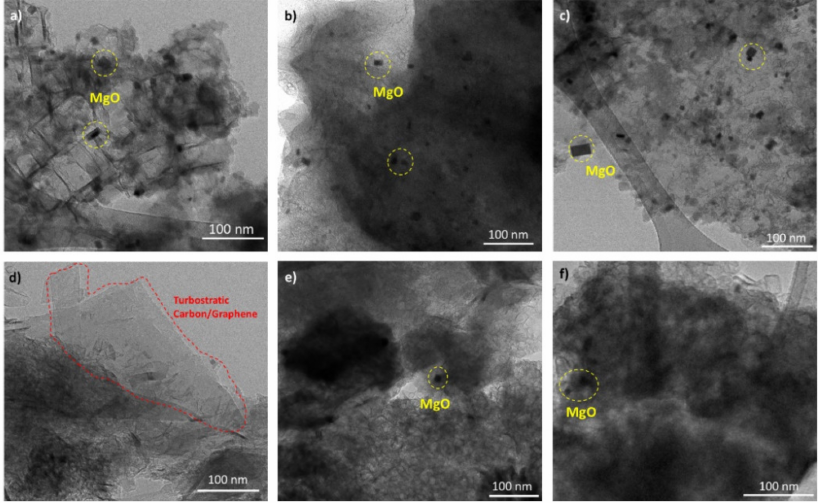
Figure 4. HRTEM images of ( a ) LM1-PP1, ( b ) LM2-PP1, ( c ) LM3-PP1, ( d ) LM1-PP2, ( e ) LM2-PP2, and ( f ) LM3-PP2